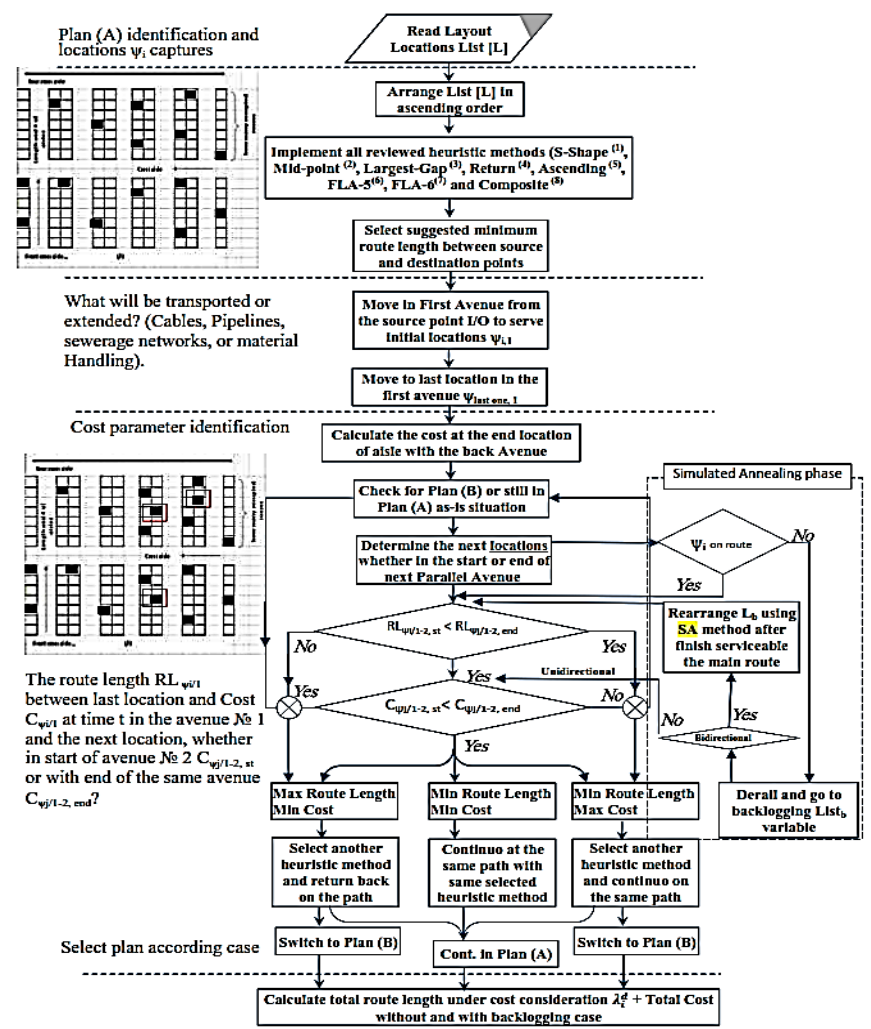
Figure 3. Proposed Minimize-Route-Length aided with simulated annealing (MRL-SA)